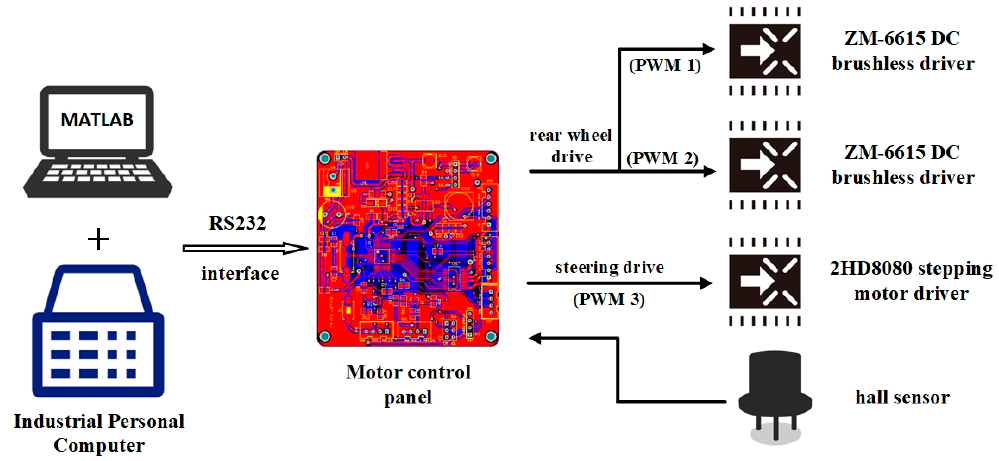
Figure 13. Robot control process.